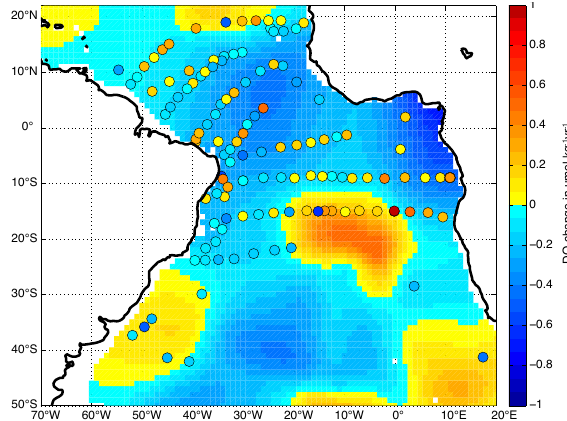
Fig. 3. Dissolved oxygen (DO) differences at 300m depth in µmolkg − 1 yr − 1 in the tropical and South Atlantic Ocean between the stations (circles) collected during the 1925 to 1927 Meteor ex- pedition and the period 1990–2008. Positive (red) values represent a DO increase in time. The background color field is the 1960 to 2010 DO trend at 300dbar from Fig.